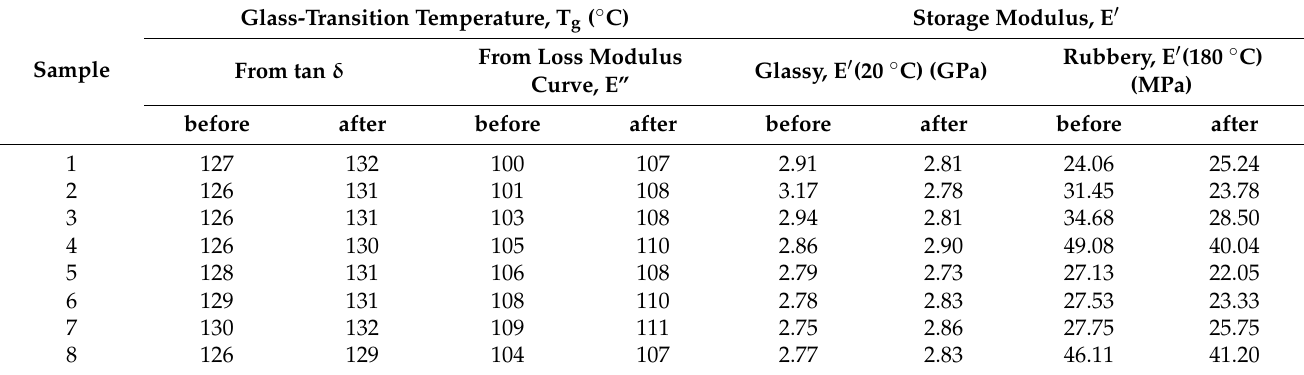
Table 3. Glass transition temperature and storage modulus in the glassy and rubbery regions (from the storage modulus curve) for the studied composites before and after the accelerated aging test.